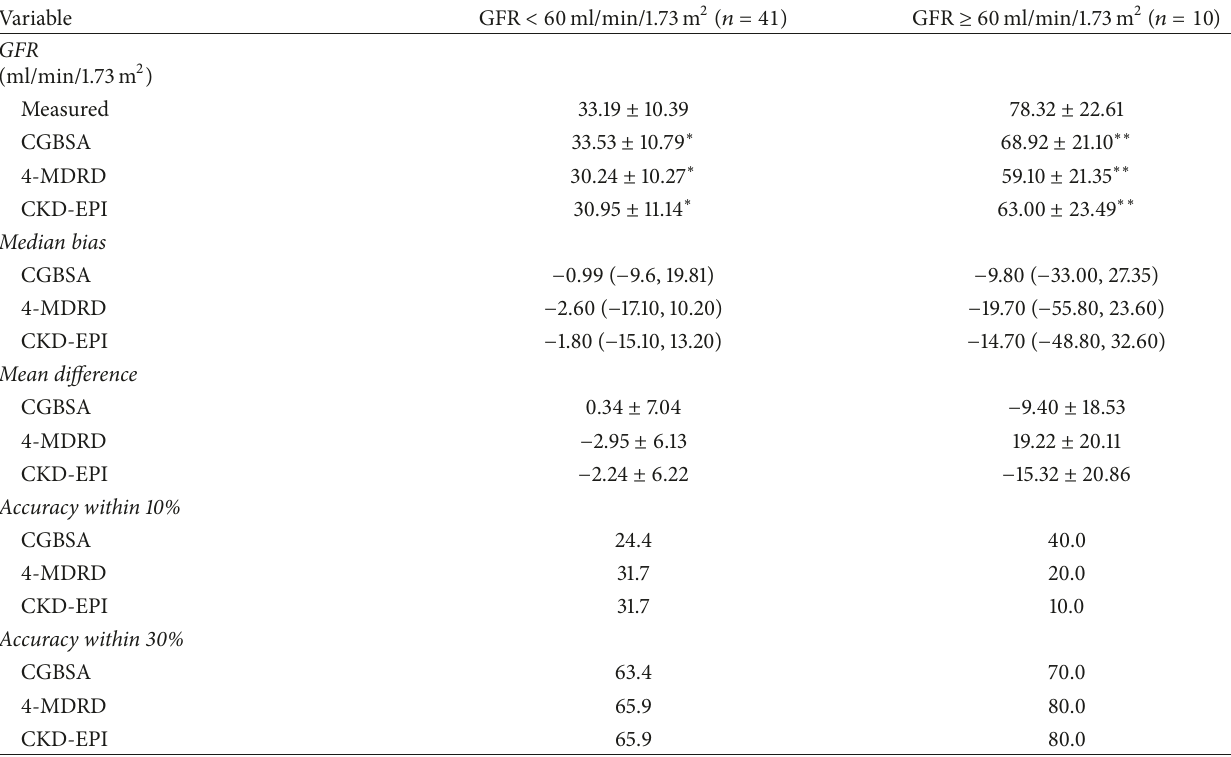
Table 4: Mean, bias, precision, and accuracy of GFR estimates within two GFR